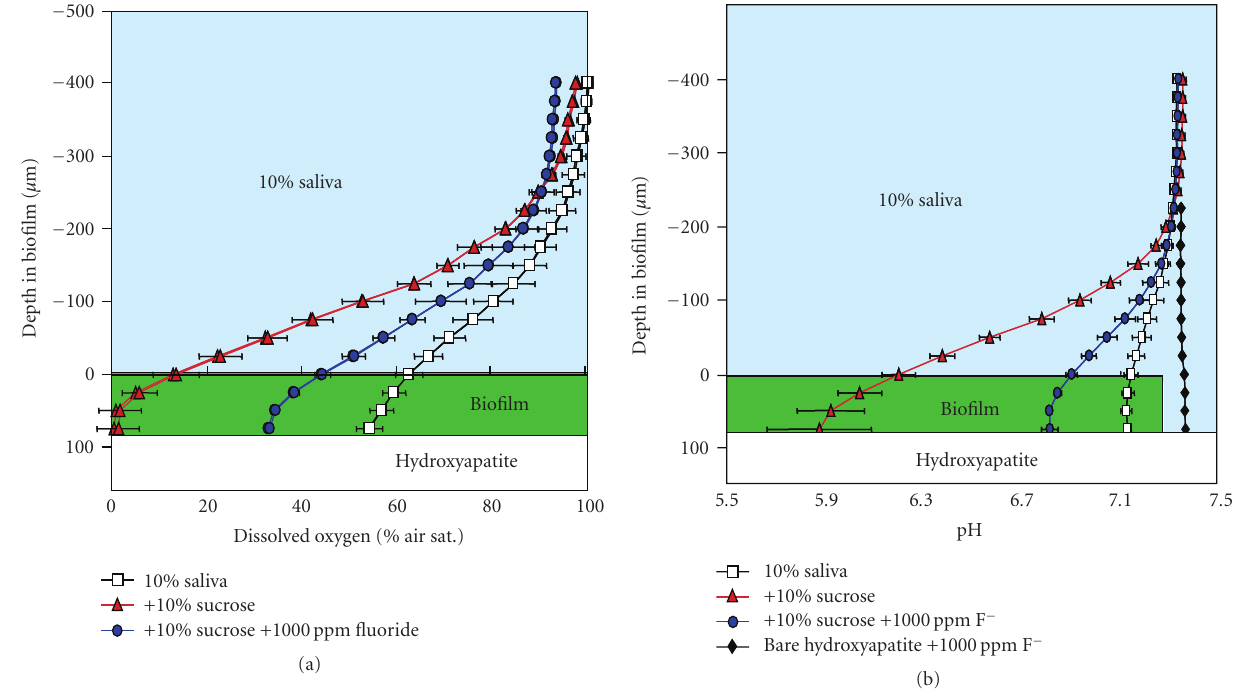
Figure 1: (a) Dissolved oxygen profile in 10% saliva after 10% sucrose addition increases anaerobicity to 50 μ m. F addition reduced biofilm activity so that dissolved oxygen increased to approximately 35% of air saturation. (b) Adding 10% sucrose decreased pH from 7.1 to 5.9 due to sucrose fermentation. F addition increased pH back to 6.8, suggesting inhibition of fermentation.